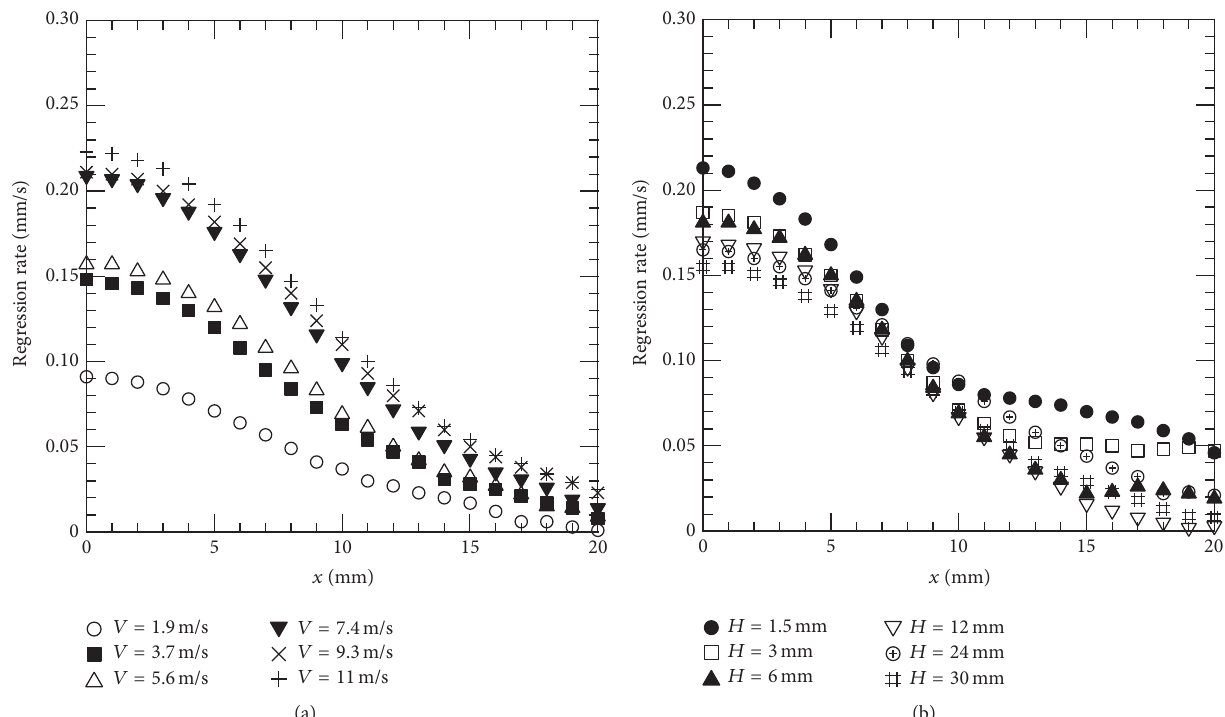
Figure 4: Local regression rate along the center line ( 𝑥 = 0 ). (a) The experiments were performed at a constant impinging distance of 24 mm and (b) at a constant impinging jet velocity of 5.6